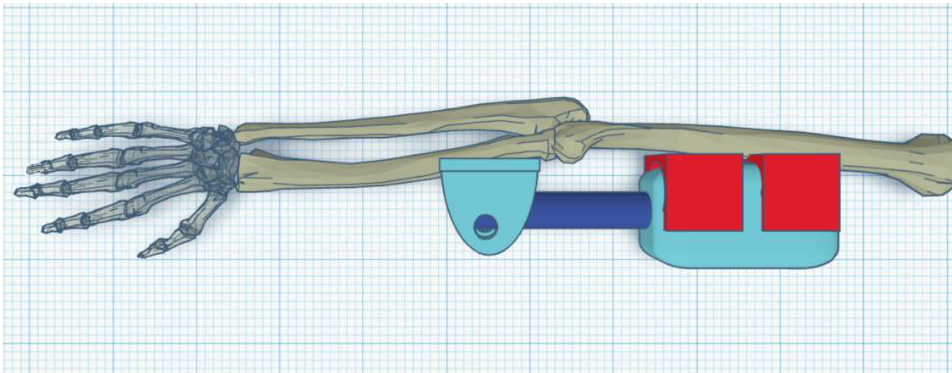
Figure 11. Parts of the exoskeleton: Concept 2 (internal). The exoskeleton is mounted on the humerus and forearm bone on the inside of the elbow (Figures 12 and 13).